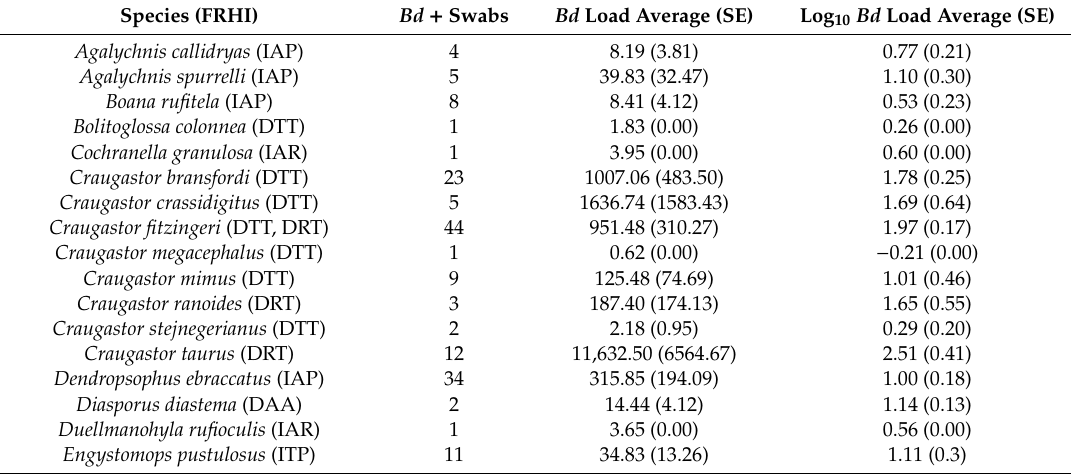
Table 4. Infection intensity in the 351 individuals where Batrachochytrium dendrobatidis ( Bd ) was quantified using qPCR in Costa Rica between 2000–2018. For every species, the table shows the foraging–reproduction habitat index (FRHI), the number of Bd positive swabs, the average (SE), and log 10 (SE) of genomic equivalents of Bd zoospores quantified per species estimated from the Bd + swabs. Symbology: First letter represents development: (I) indirect or (D) direct-developing amphibians. Second letter represents foraging habitat: terrestrial (T), arboreal (A), pond / puddle-dwellers (P), stream-breeders (R), and phytotelma (F). Third letter represents reproductive habitat: terrestrial (T), arboreal (A), pond / puddle-dwellers (P), stream-breeders (R), and phytotelma (F). Species (FRHI) Bd + Swabs Bd Load Average (SE) Log 10 Bd Load Average